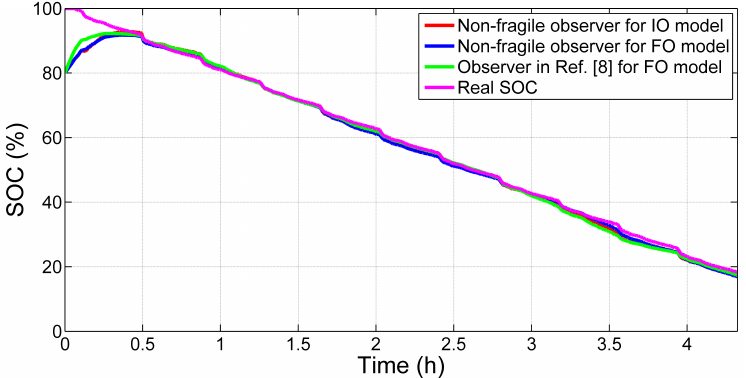
Figure 7. SOC estimation profiles for UDDS.